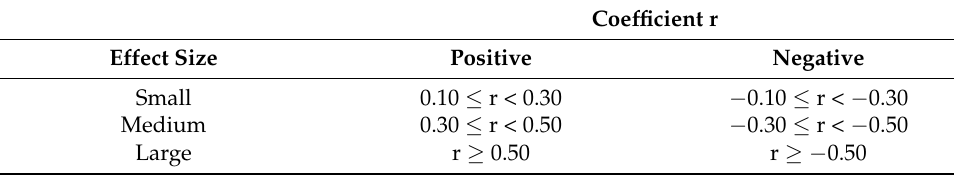
Table 1. Interpretation of the effect size for nonparametric samples [51].